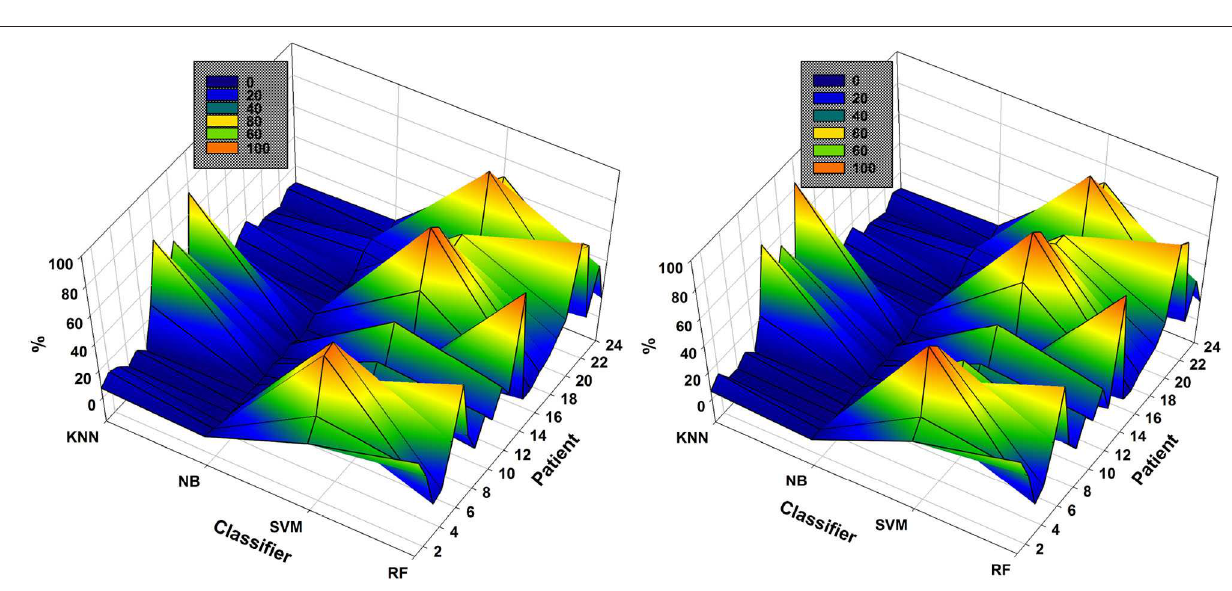
FIGURE 6 | Comparison of the most used classifiers by NSGA-II (left) and NSGA-III (right) in the 24 patients with EMD-based feature